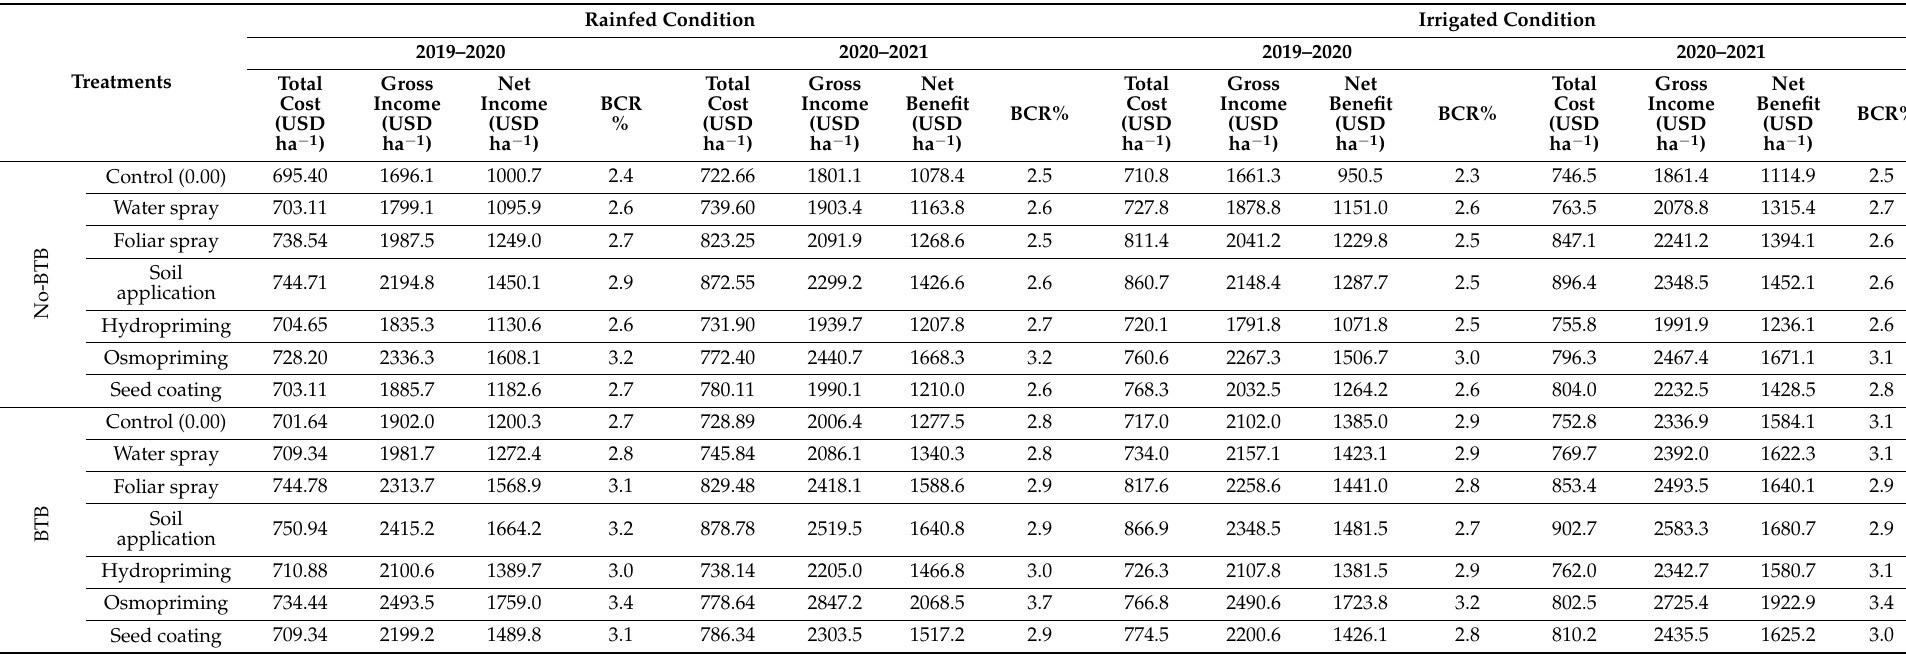
Table 9. Effects of B application methods along with BTB strain on economic analysis of desi chickpea during 2019–2020 and 2020–2021.